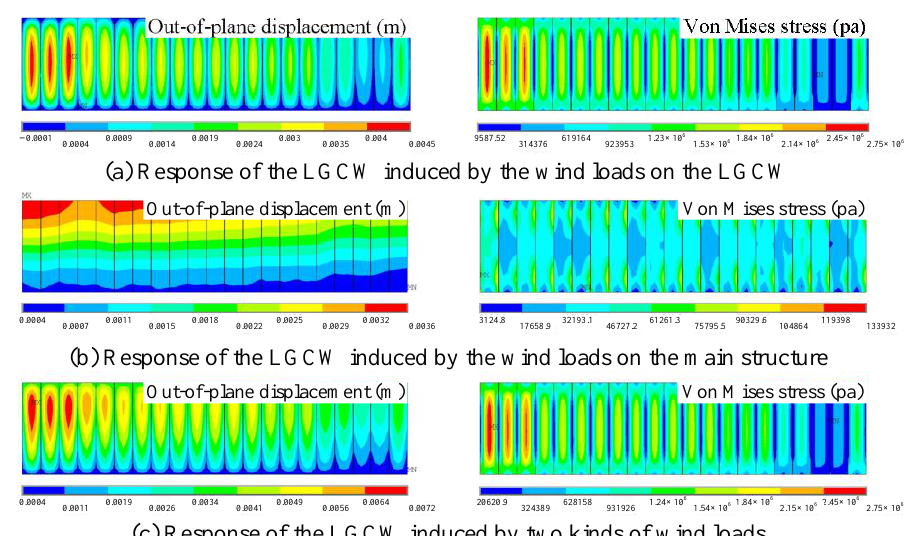
Figure 10. Response distribution of the LGCW at 90°. Figure 11 displays the peak response of each glass panel at 0° and 90°, and the peak response of each glass panel appears at different locations of each glass panel. In case (b), the peak additional out-of-plane displacements and von Mises stresses induced by the high-rise building of each glass panel are almost the same, and the magnitudes of the peak out-of-plane displacements at 0° are larger than those at 90°. In case (c), the peak out-of- plane displacements of glass panels increase significantly in comparison to those of case (a), and the peak out-of-plane displacement of the whole LGCW at 0° (the peak out-of- plane displacement of glass panel #18) increases from 11.1 mm to 15.6 mm, i.e., by 40.5%, while the peak out-of-plane displacement of the whole LGCW at 90° (the peak out-of- plane displacement of glass panel #3) increases from 4.5 mm to 7.1 mm, i.e., by 57.4%. Since the peak additional von Mises stresses of the whole LGCW at 0° and 90° in case (b) are very small, the peak von Mises stresses of the whole LGCW changes a little in comparison to case (a).